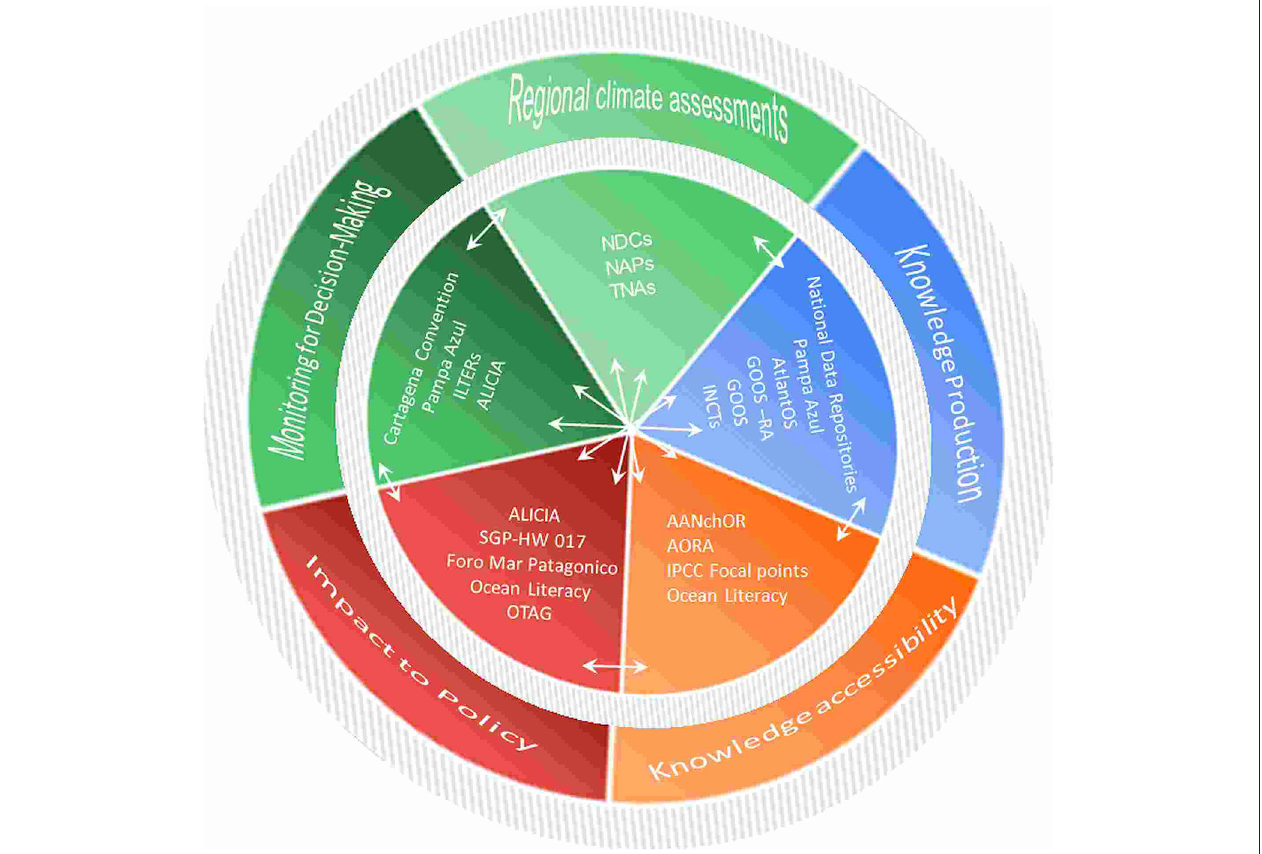
FIGURE 1 | Examples of current initiatives that can narrow the gaps and explore opportunities for the uptake of ocean and climate science to political decision making in LA across five key categories: (i). climate assessment information and regional policies, (ii). knowledge production, (iii). knowledge accessibility, (iv). knowledge impact to policy, and (v). long-term monitoring for decision-making. (Note see Table S1 for additional information and references).